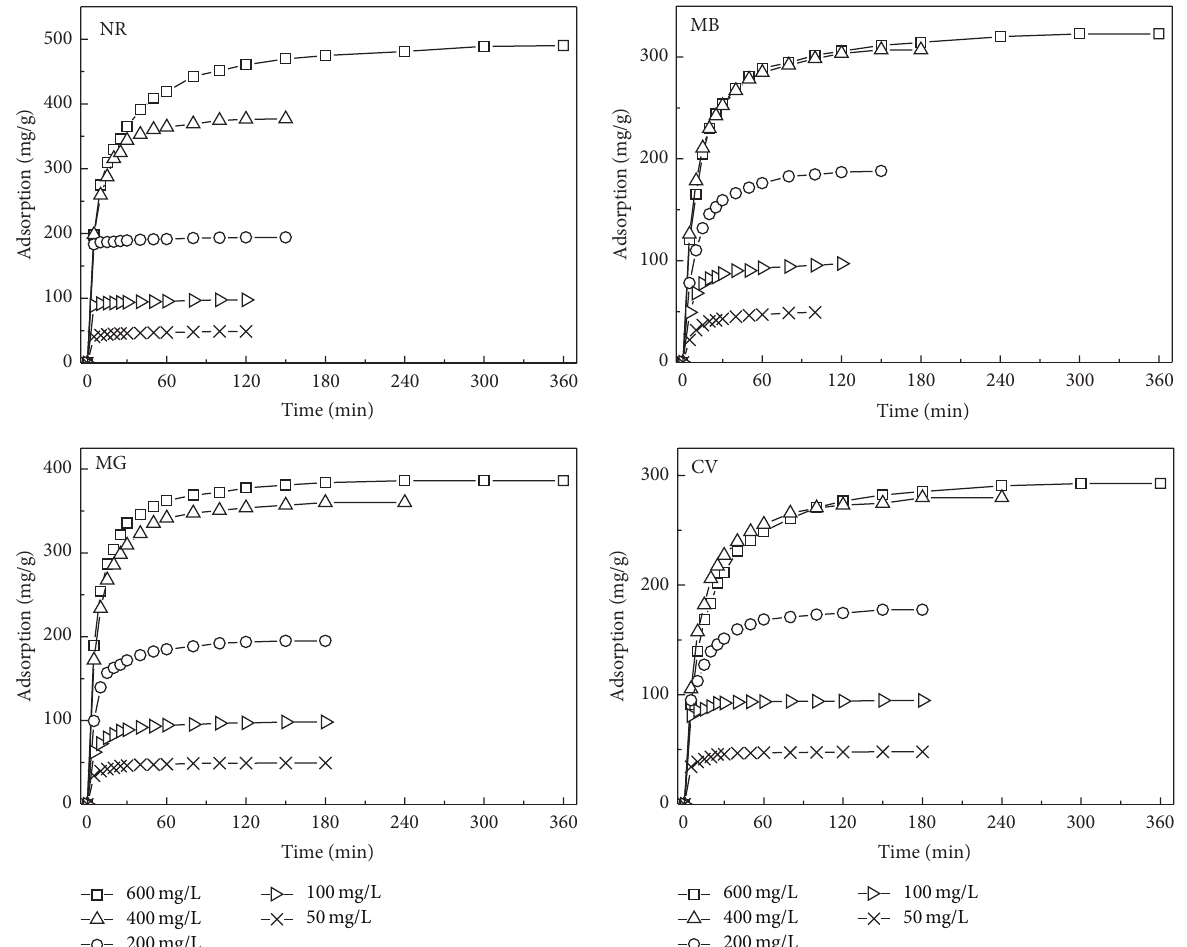
Figure 8: The adsorption curves of NR, MB, MG, and CV at different initial concentration (TN-TP dosage